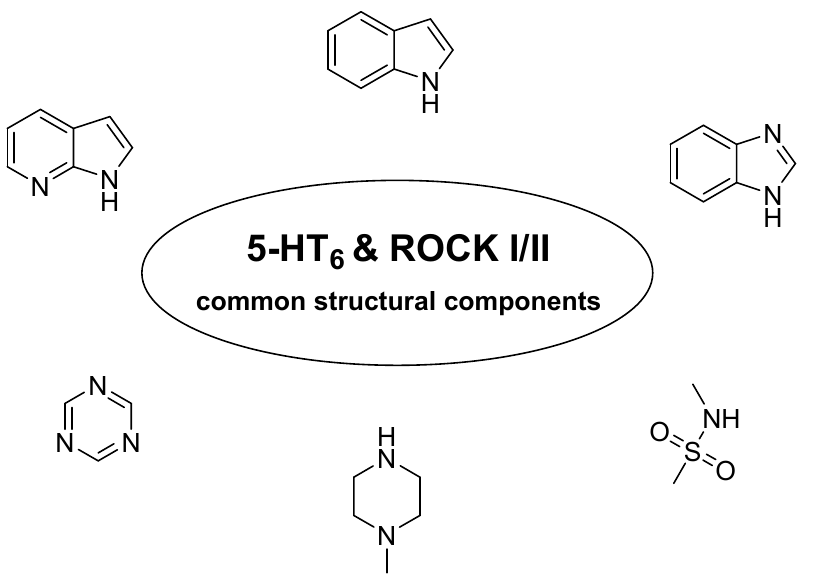
Figure 11. Common structural elements found in 5-HT 6 R ligands and ROCK I/II inhibitors.